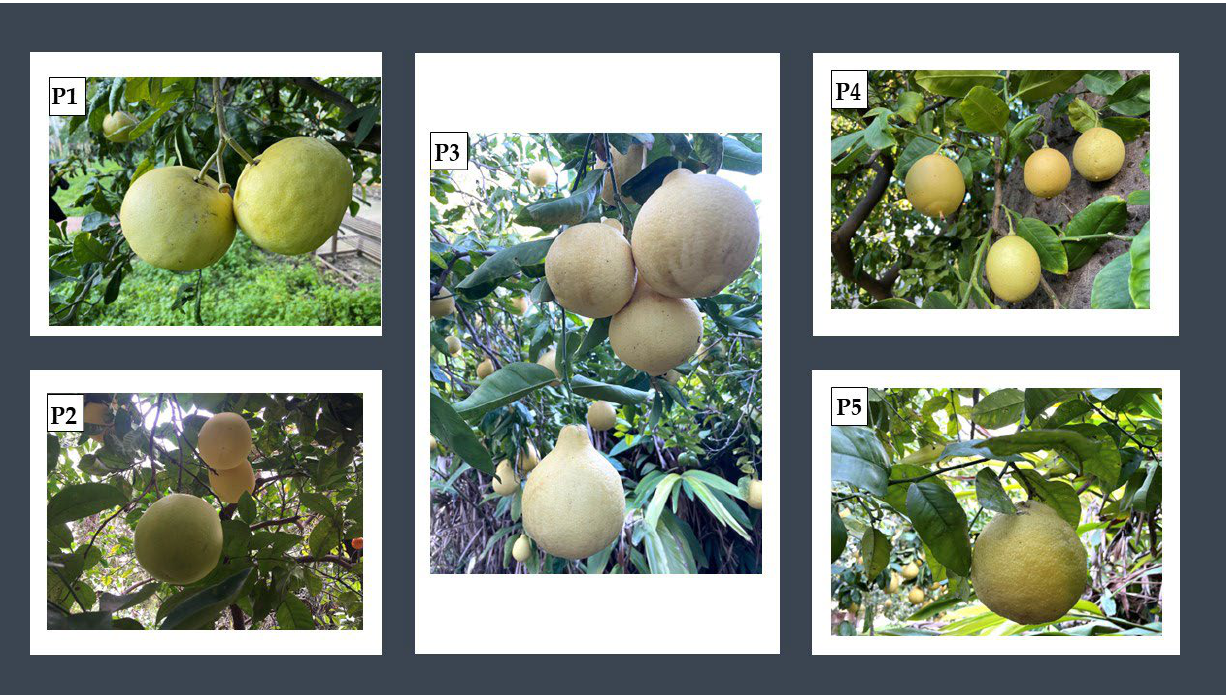
Figure 1. The five C. maxima cultivars grown in the Palermo Botanical Garden: C. maxima ‘Chadock’ ( P1 ), C. maxima ‘Maxima’ ( P2 ), C. maxima ‘Pyriformis’ ( P3 ), C. maxima ‘Terracciani’ ( P4 ), and C. maxima ‘Todarii’ ( P5 ).